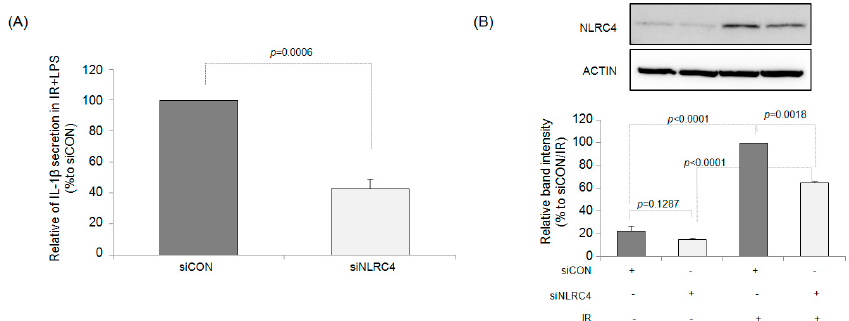
Figure 5. siNLRC4 transfection suppressed the increase in IL-1 β production by irradiation in LPS-stimulated macrophages. ( A ) Changes in IL-1 β production in RAW264.7 macrophage cells transfected with either NLRC4 siRNA or scramble siRNA. ( B ) Representative western blotting image of NLRC4 protein expression with relative band intensity quantification data (% to IR treated siCON). Results are expressed as mean ± S.E.M.